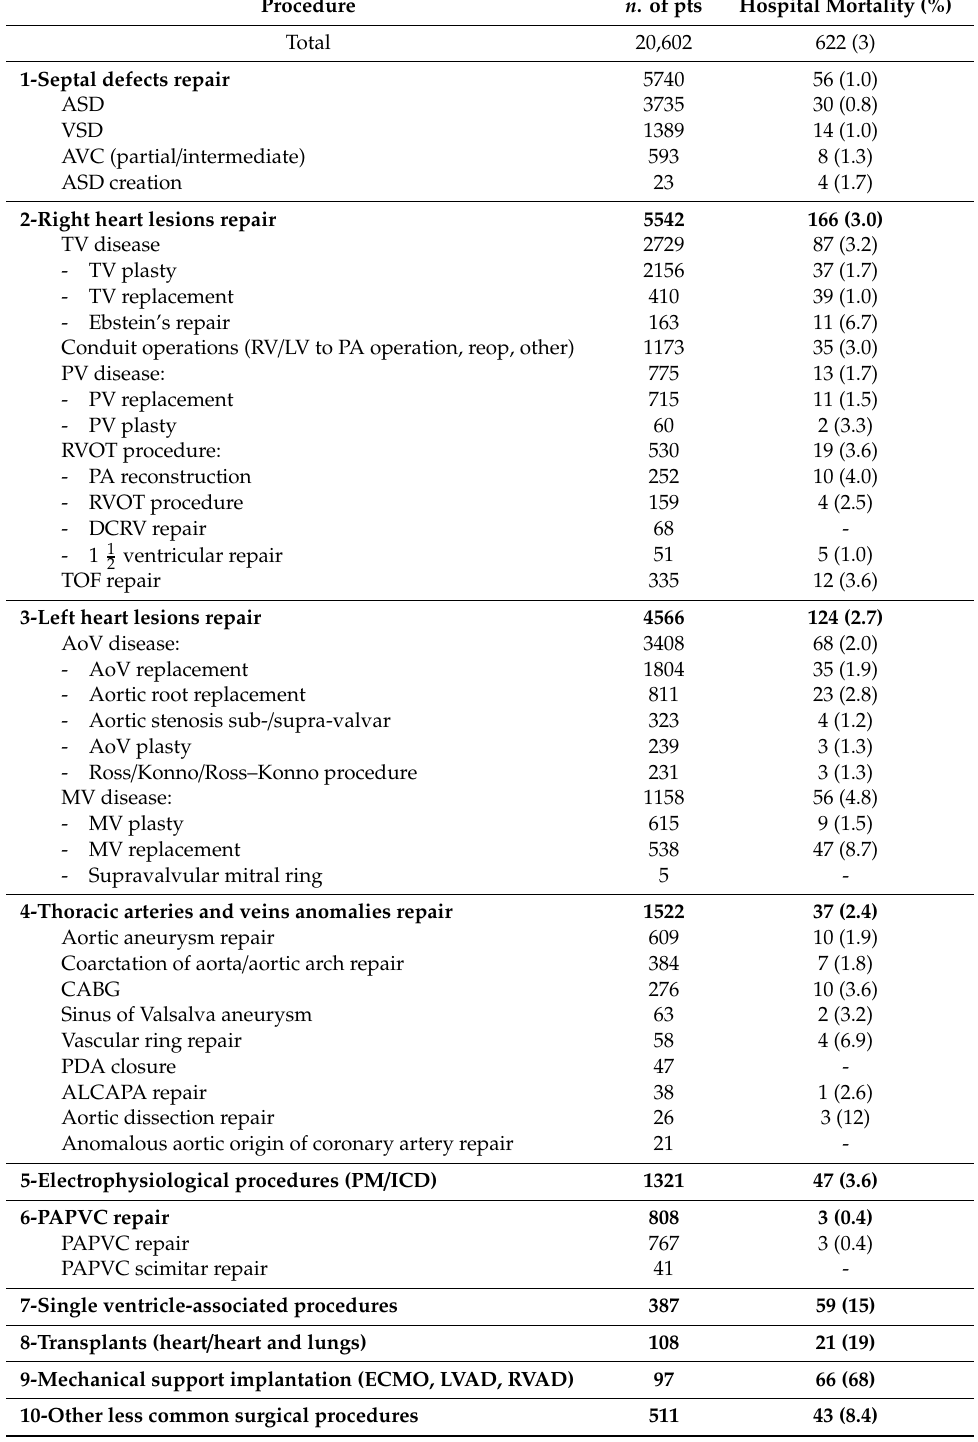
Table 2. Hospital mortality according to procedural groups and main procedure leading to